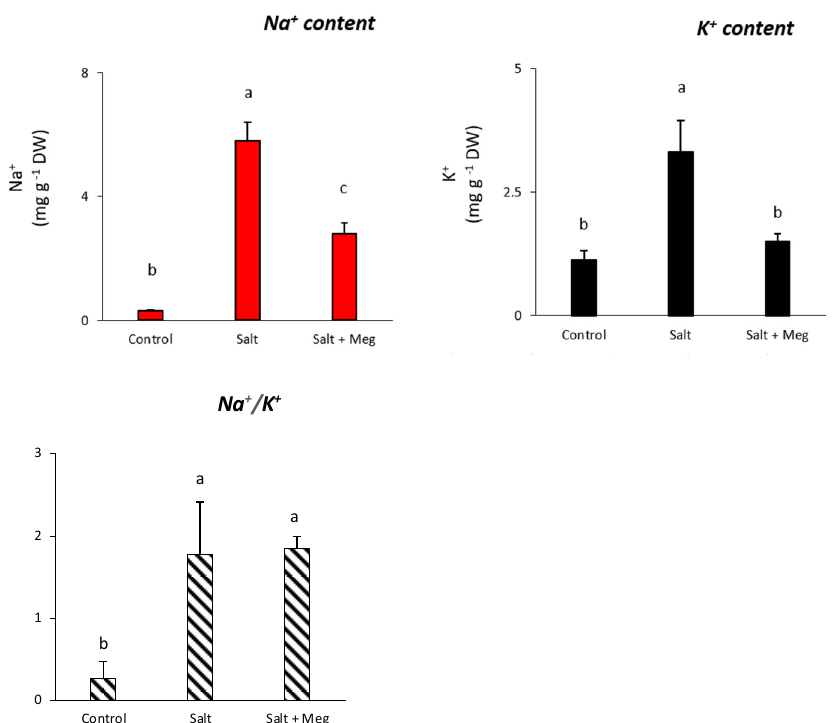
Figure 1. Contents of sodium (Na + ), potassium (K + ) and their ratio in maize seedling controls, and grown with NaCl alone, and NaCl with the biostimulant (i.e., Control, Salt, Salt + Meg, respectively). Different letters within each column indicate statistically significant differences at p ≤ 0.05.